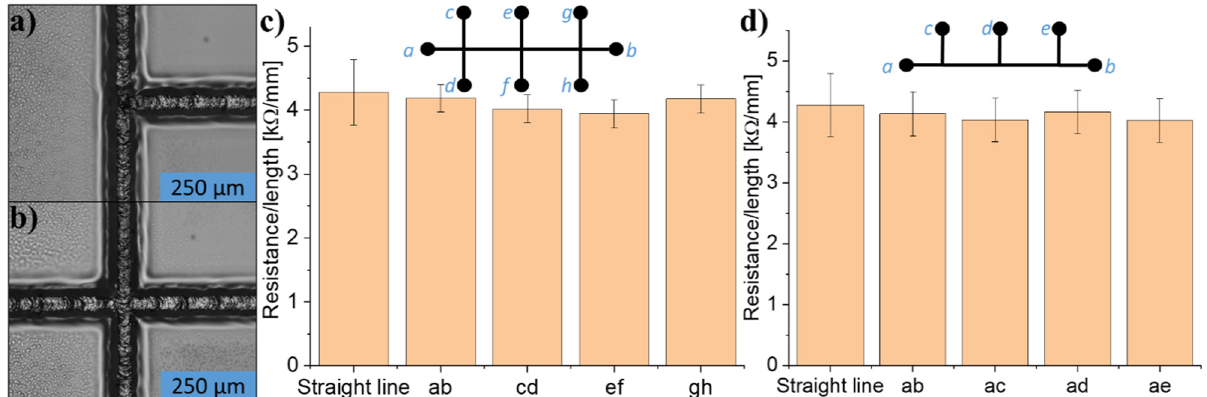
Figure 12. ( a , b ) show the joining and intersecting of two laser-pyrolyzed lines. The vertical lines are written first, the horizontal lines are written second. ( c , d ) show resistance per path length measured between the points shown on the schematic insets compared to the resistance of a straight line written with the same parameters. All lines were written at 80 mW power, 0.1 mm/s scan speed, using two scans. The error bars are based on the standard deviation ( n ≥ 3).